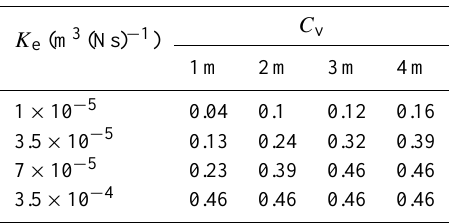
Table 3. Results of erosion sensitivity analysis in Test